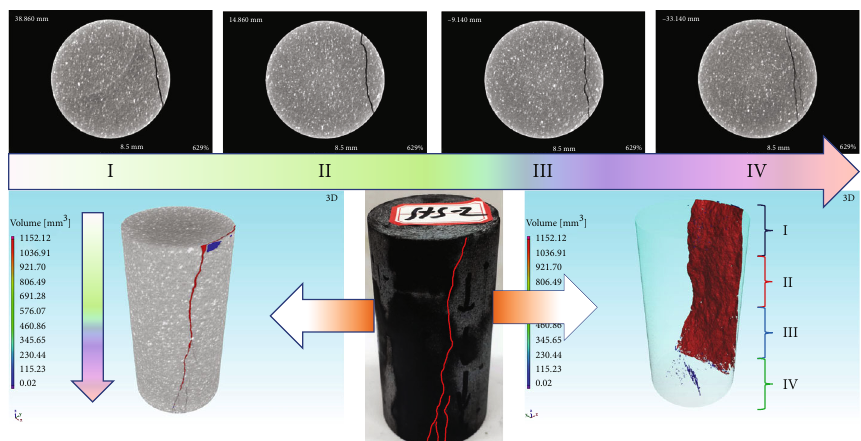
Figure 10: Fracture development and spatial